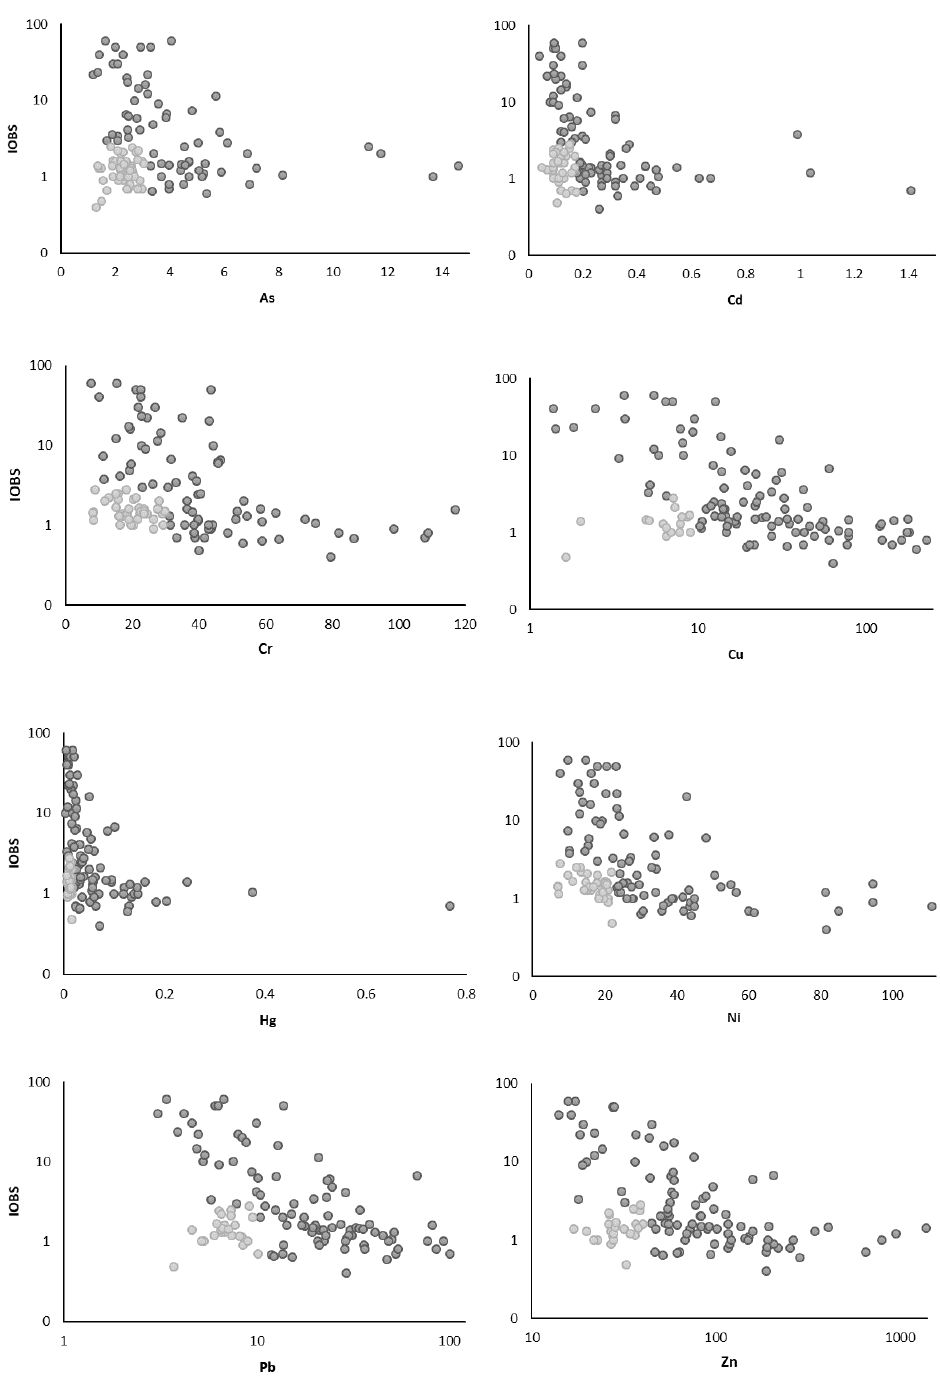
Figure 1. Relationships between the concentrations of Cr, Ni, Zn, Cu, Pb, Cd, Hg, As ( µ g / g dry weight) and the Oligochaete index of sediment bioindication (IOBS) index. The entries showing both a biological effect (IOBS < 3) and a concentration of metal < 2 ‐ fold the background concentration are in light grey. These data were not used in the derivation of the TEL oligo threshold values. All other samples are in dark grey.